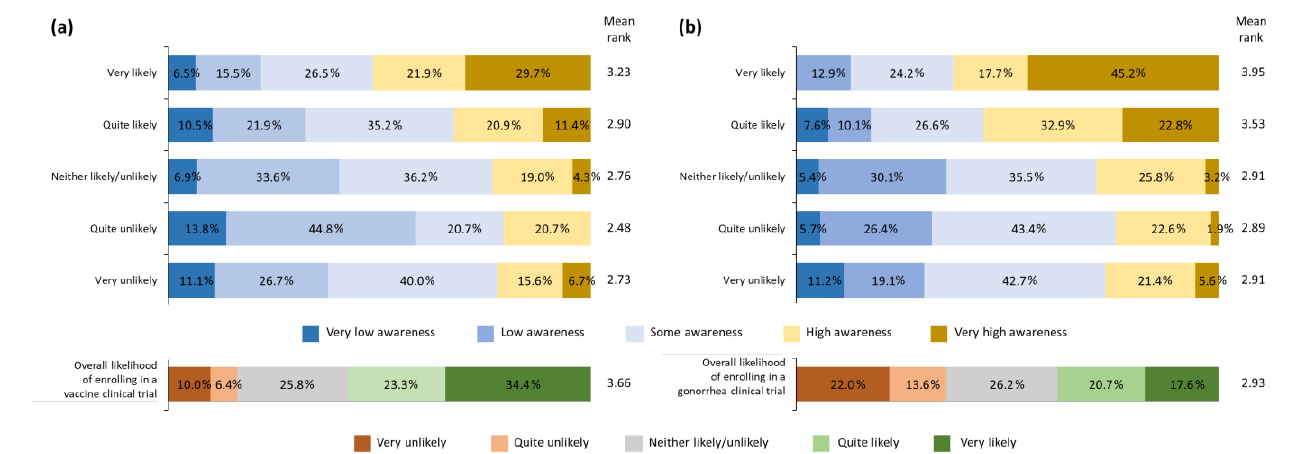
Figure 3. Willingness to enroll in ( a ) a general clinical research trial or ( b ) a gonorrhea vaccine trial according to self-declared knowledge. Correlation between self-declared knowledge and willing- ness to enroll in a general vaccine clinical trial: Spearman’s ρ = 0.277, p < 0.001, and a